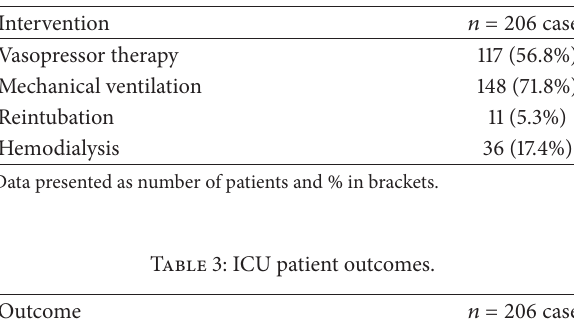
Table 2: Interventions during course in ICU.